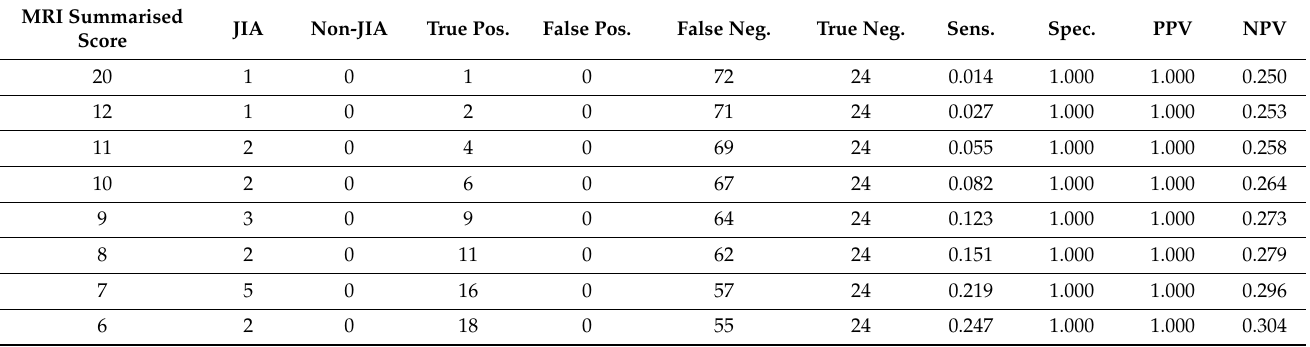
Table 4. Diagnostic value of the summarized MRI score as a predictor of